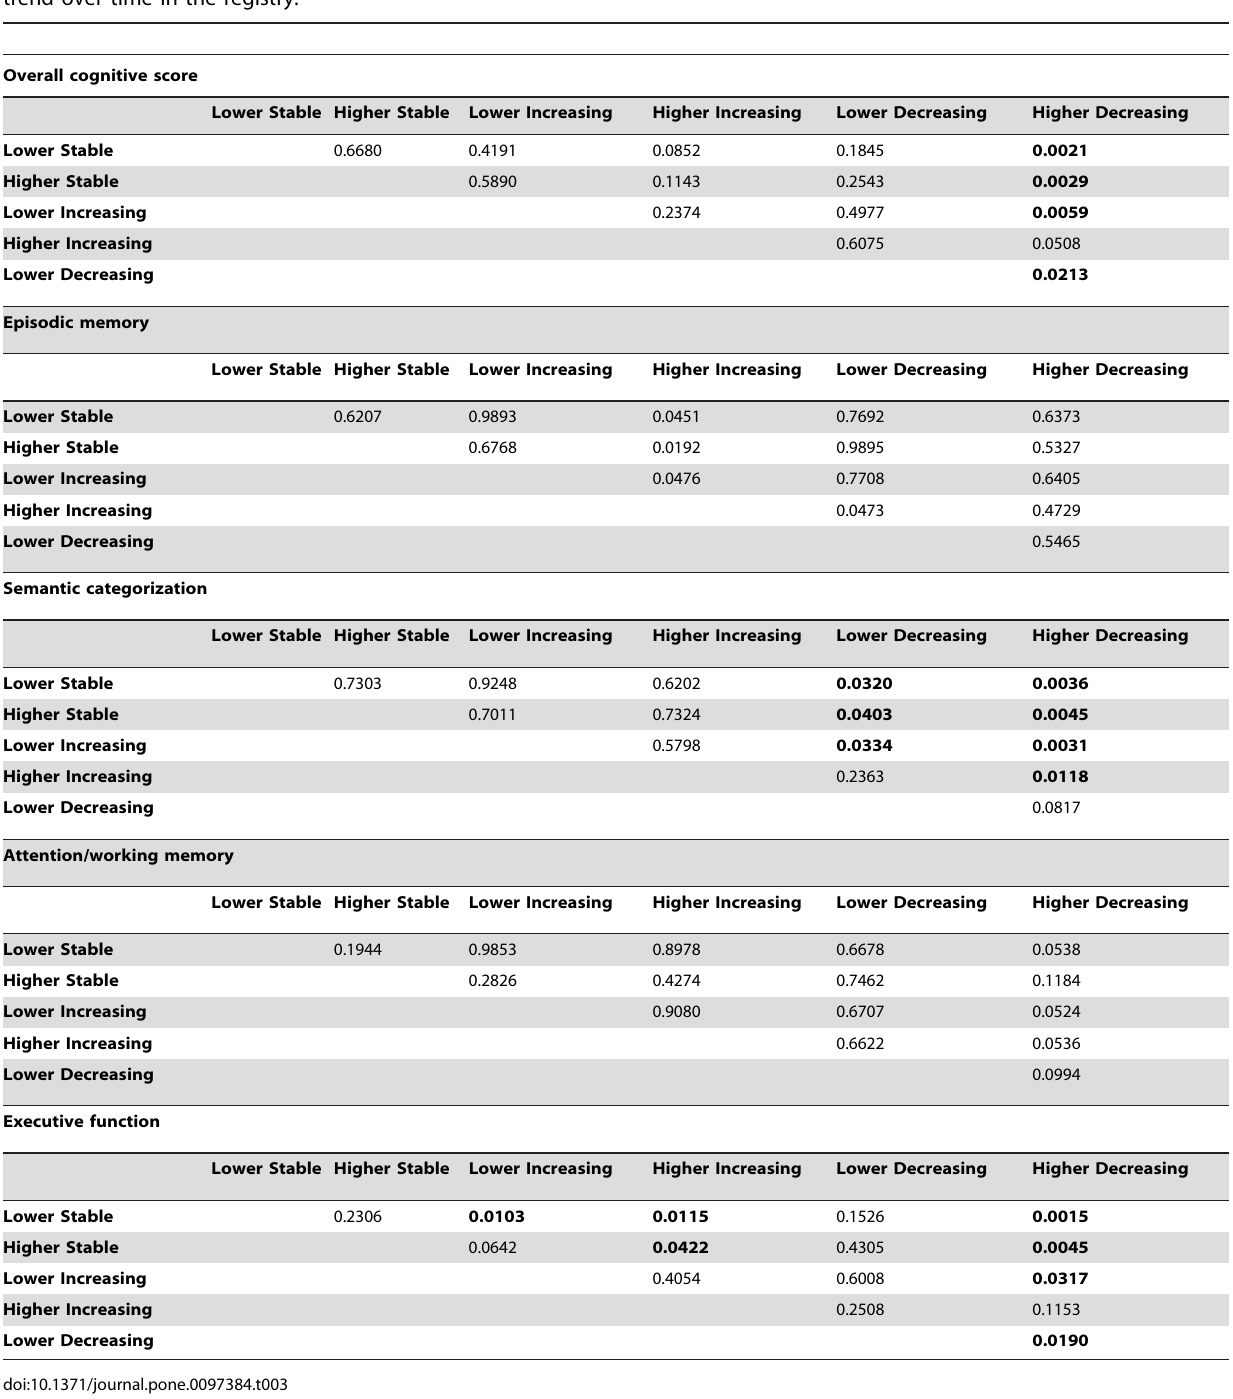
Table 3. Comparisons between cognitive scores in groups of subjects defined by HbA1c at entry into the Diabetes Registry and trend over time in the